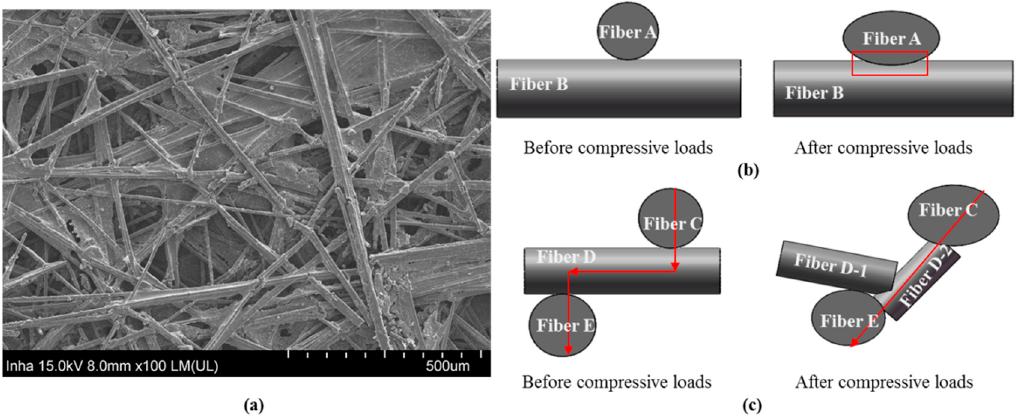
Figure 7. Connectivity of carbon fibers in the porous layer: ( a ) SEM image of the porous layer after compressive loads; ( b ) schematics of carbon fiber connection without crack; ( c ) schematics of carbon fiber connection with crack.